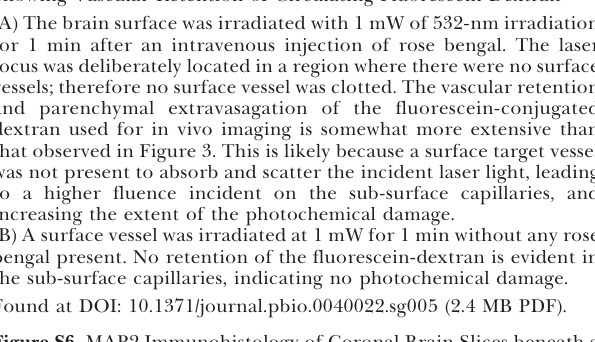
Figure S1. Schematic of the Two-Photon Laser Scanning Microscope (TPLSM)